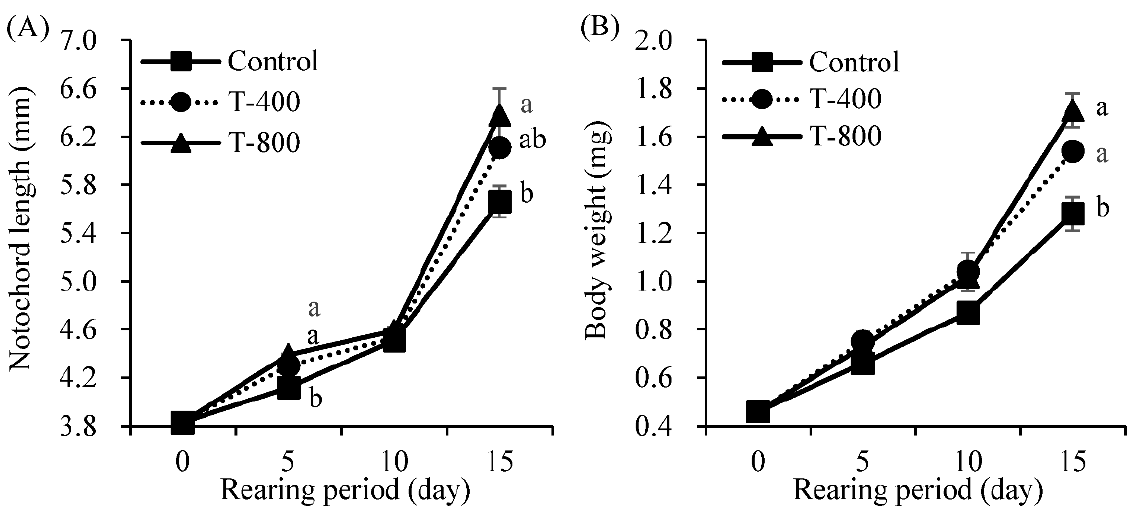
Figure 1. Notochord length (( A ), n = 3 tanks) and body weight (( B ), n = 3 tanks) of small yellow croaker fed different taurine-enriched rotifers. Vertical bar indicates the standard error of mean values of triplicate tanks. Different superscripts within each row are significantly different ( p < 0.05) by Tukey’s test. Three different taurine (T) enrichment levels, including 400 mg/g (T-400) and 800 mg/g (T-800). Table 4. Free amino acid content of small yellow croaker larvae fed with the various taurine-enriched rotifers for 15 days (mg/g,